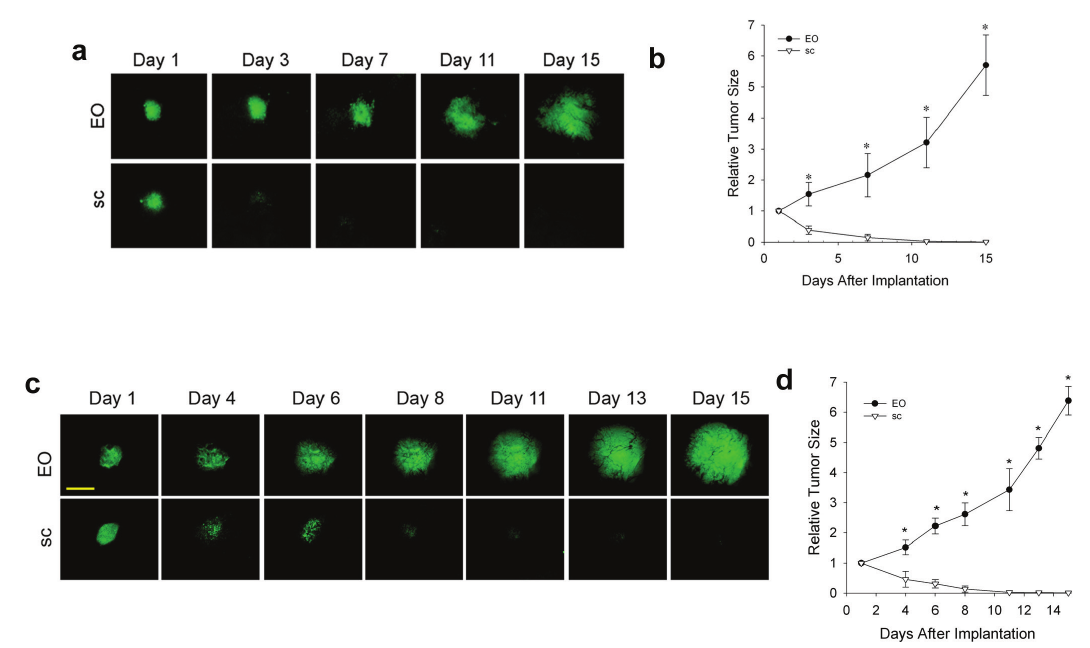
Supplementary figure 2. Effect of orthotopic tissue co-implantation on TRAMP C2 and MOVCAR16 tumor growth. Fluorescence images ( a and c ) and growth curves ( b and d ) of TRAMPC2 ( a and b ) and MOVCAR-16 ( c and d ) tumor spheroids expressing H2B-GFP that were implanted directly onto the dorsal skin (sc) or with respective orthotopic donor tissue (EO) (prostate and ovary respectively) and monitored through the dorsal skin window chamber by IVM at the indicated times. ( b and d ) Relative tumor fluorescence signal was measured by total GFP intensity relative to day 1. Scale bar = 500 μm. n = 3–4 mice for all experiments.